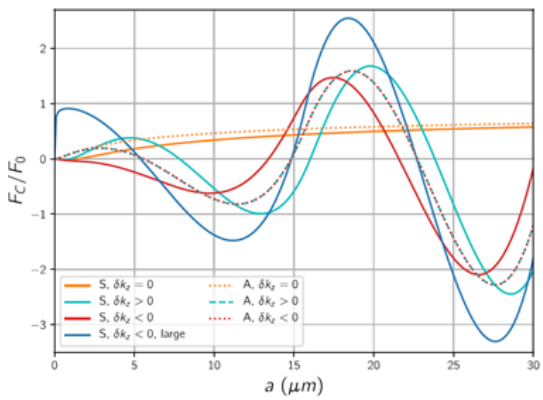
Figure 3. Casimir force between Weyl semimetals filled with chiral medium normalized to the one for perfect metals 𝐹 0 = − ℏ𝑐𝜋 as a function of separation. Here 𝛿𝑘 𝑧 = 𝒱𝐵 ( 𝒱 —Verdet constant, 240𝑎 4 𝐵 —applied magnetic field); 𝛿𝑘 𝑧 = 0 corresponds to a vacuum filled gap, while the nonvanishing 𝛿𝑘 𝑧 = ±2 × 10 5 m −1 . In addition, 𝜎 𝑥𝑦 = 265 × 10 6 m −1 . The curves marked with 𝑆 correspond to 𝜎 𝑥𝑦1 = 𝜎 𝑥𝑦2 , while the rest correspond to 𝜎 𝑥𝑦1 = −𝜎 𝑥𝑦2 . The line marked as “large” correspond to 𝜎 𝑥𝑦1 = 2650 × 10 6 m −1 (Figure is taken from reference [60]). 𝑐